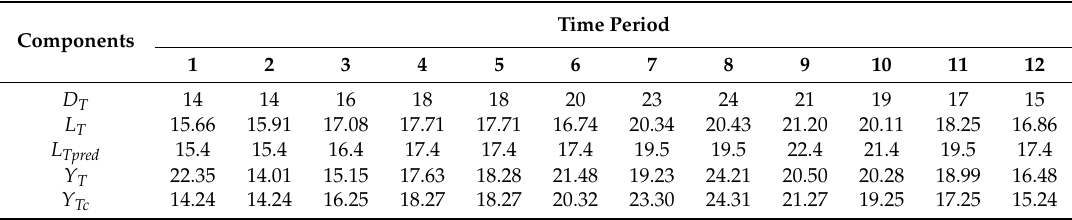
Table 5. Parametric values and forecasts for the test period.